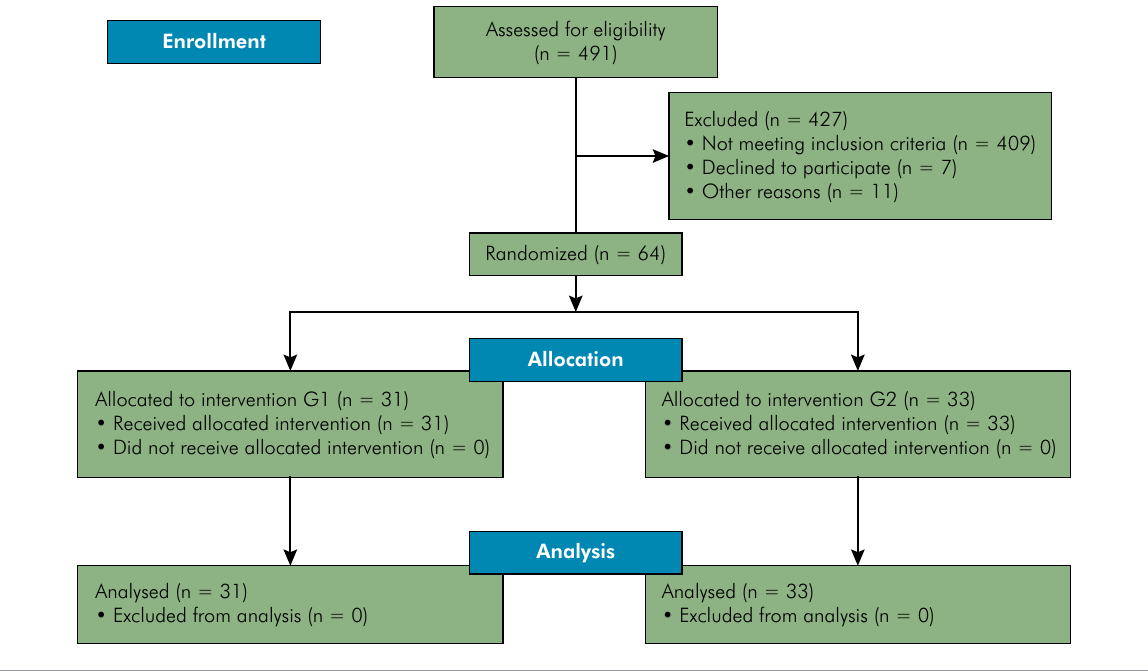
Figure 2. Flowchart of participants’ assessment adapted from